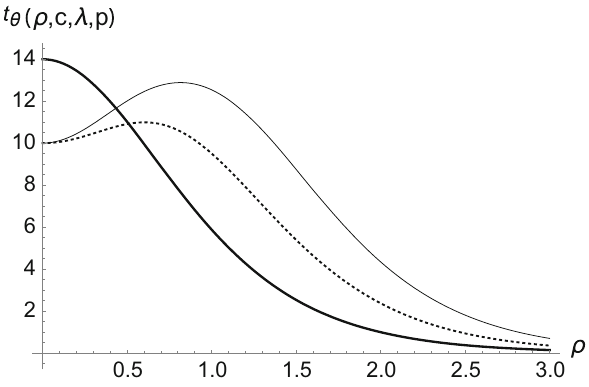
Fig. 3 Angular metric component for c /λ = 2 (thick line), c /λ = 4 (thin line) and c /λ = 6 (dotted line)